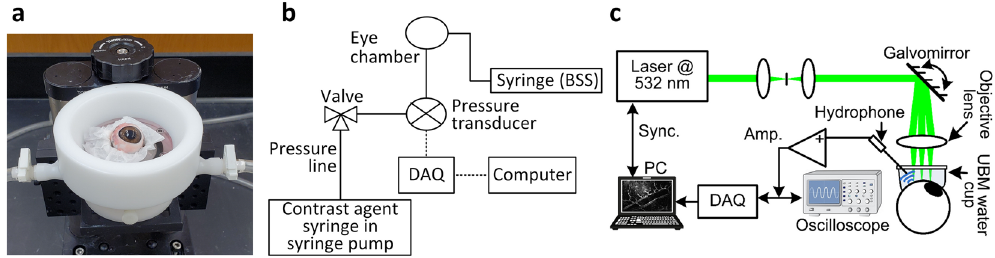
Figure 1. Experiment setup. ( a ) Globe holder and hydration system, ( b ) perfusion system, ( c ) photoacoustic imaging